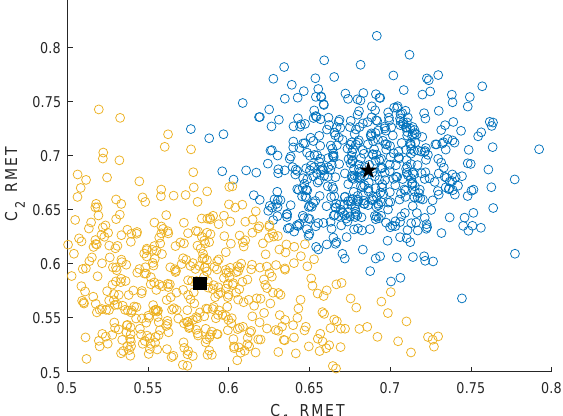
Figure 4. Clustering effect of the ratios of the maximum eigenvalue to the trace (RMETs) under the Rayleigh